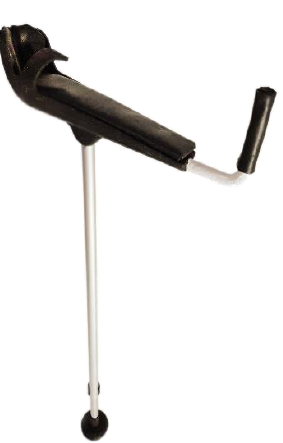
Figure 13. Digital Prototype.